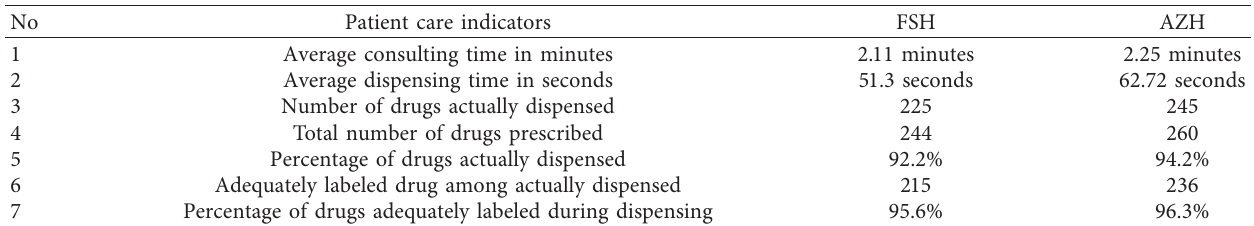
Table 4: Patient care indicators from October 11 to November 30, 2019, at FSH and AZH, northwest Ethiopia ( n � 100). No Patient care indicators